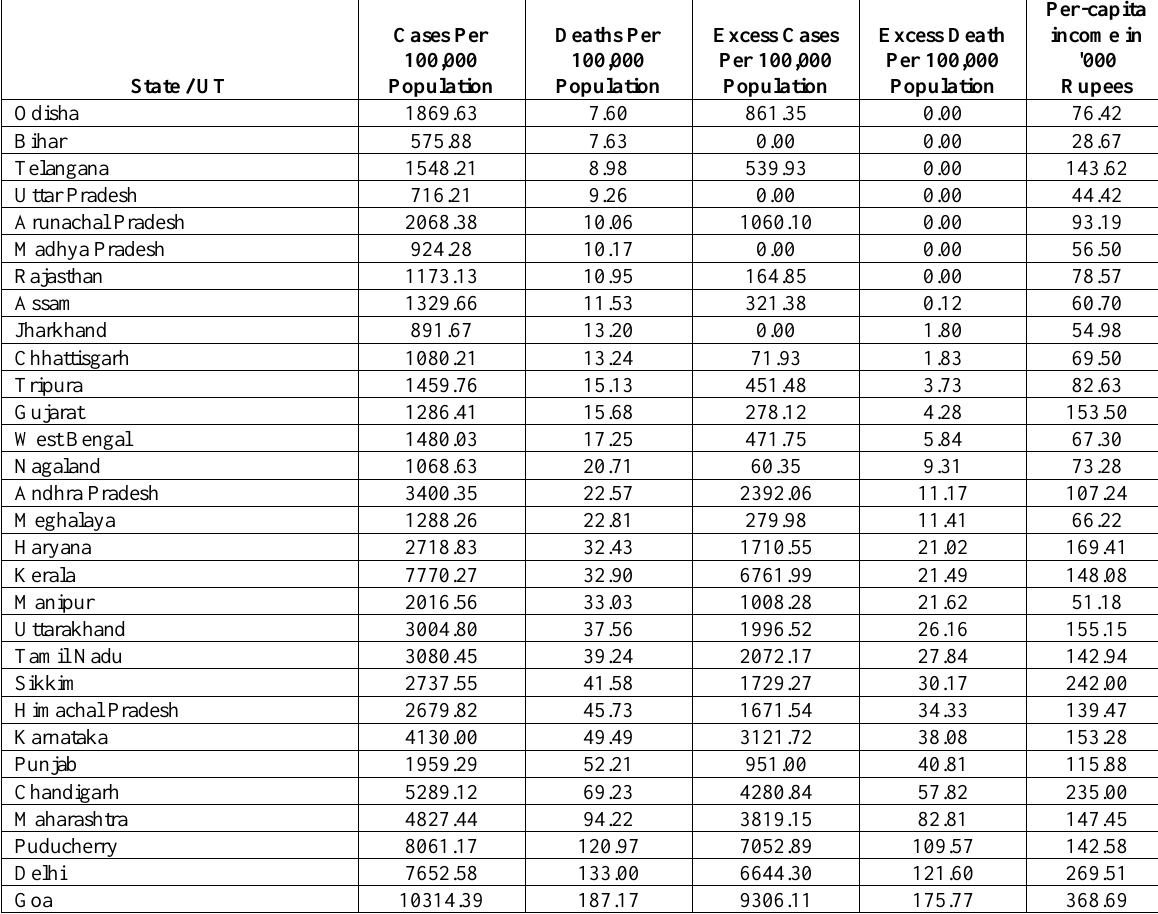
Table 1. Excess Cases and Excess Death in a Sample of Indian States and UTs